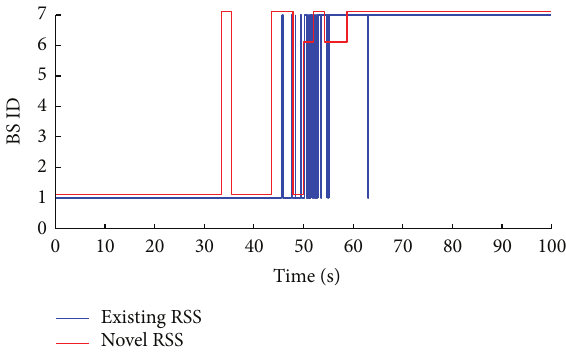
Figure 5: BS prediction using RSS prediction approach.